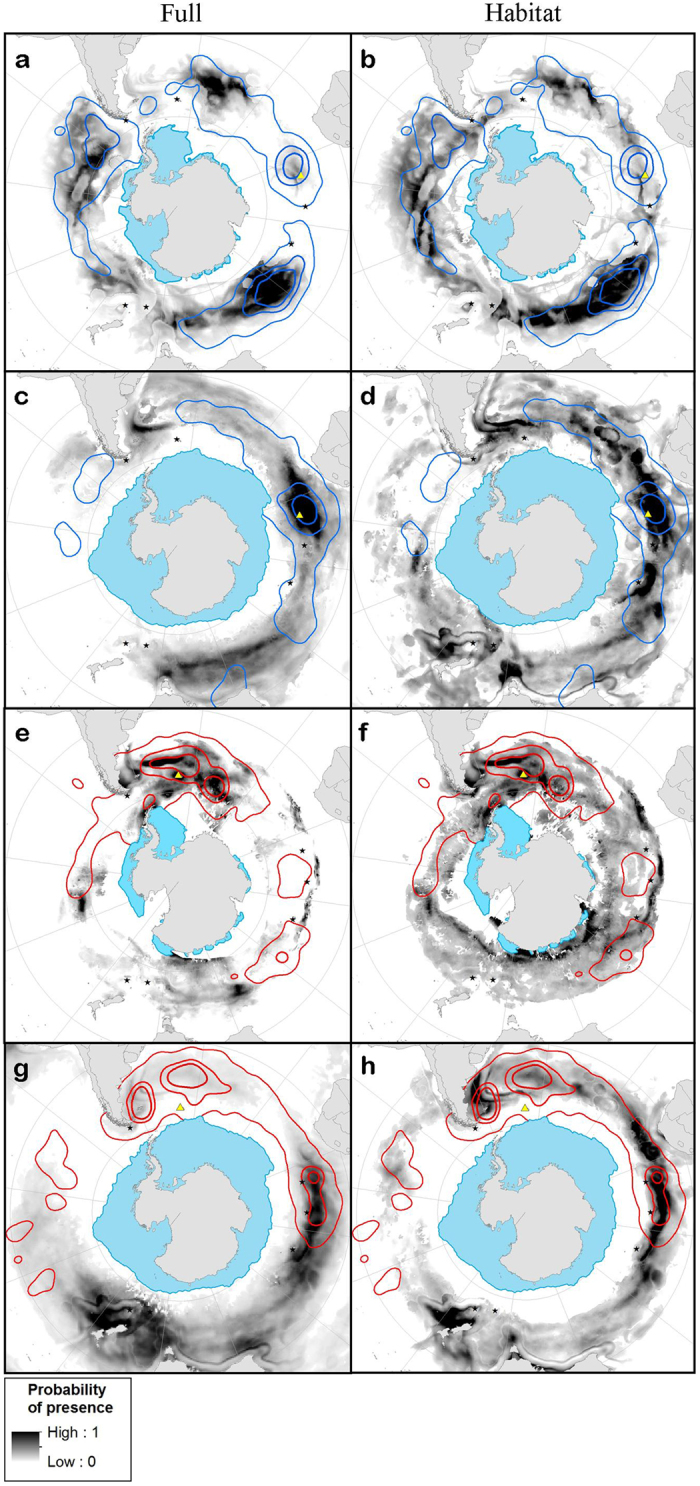
Map of the spatial predictions from the full models (left: a, c, e, g), and those just taking into account habitat preferences (right: b, d, f, h). Maps show modelled probability of presence in greyscale of birds from different populations in summer and winter; Prince Edward Islands (PEI) summer (a, b), and winter (c, d), South Georgia (SG) summer (e, f), winter (g, h). The 25%, 50% and 90% kernels of observed distributions are shown for PEI and SG birds in blue and red, respectively. The minimum summer or maximum winter sea ice extents (>15%) are shown as blue polygons and colonies of origin as yellow triangles (maps produced by ArcGIS 10.1 software, http://www.arcgis.com/features).